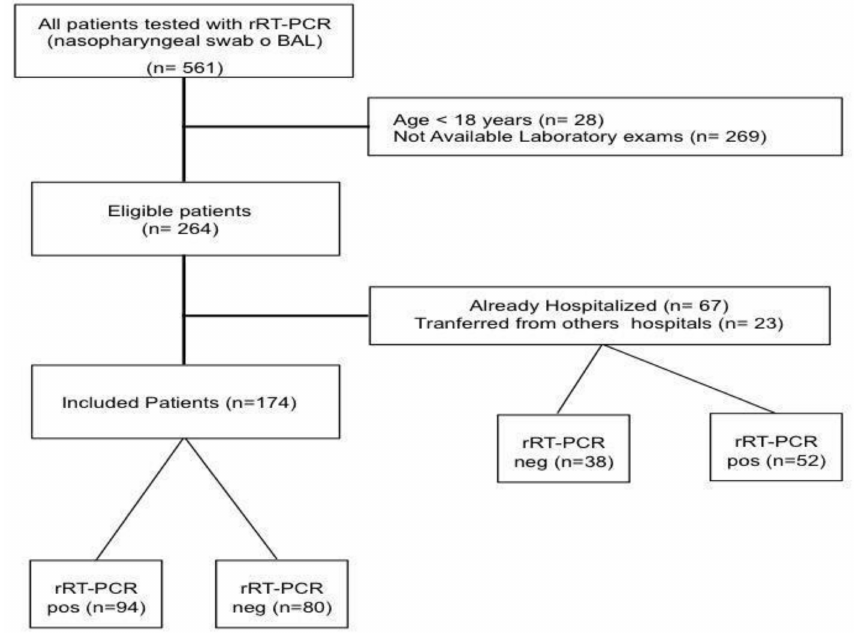
Figure 1. Flow-chart of the study.